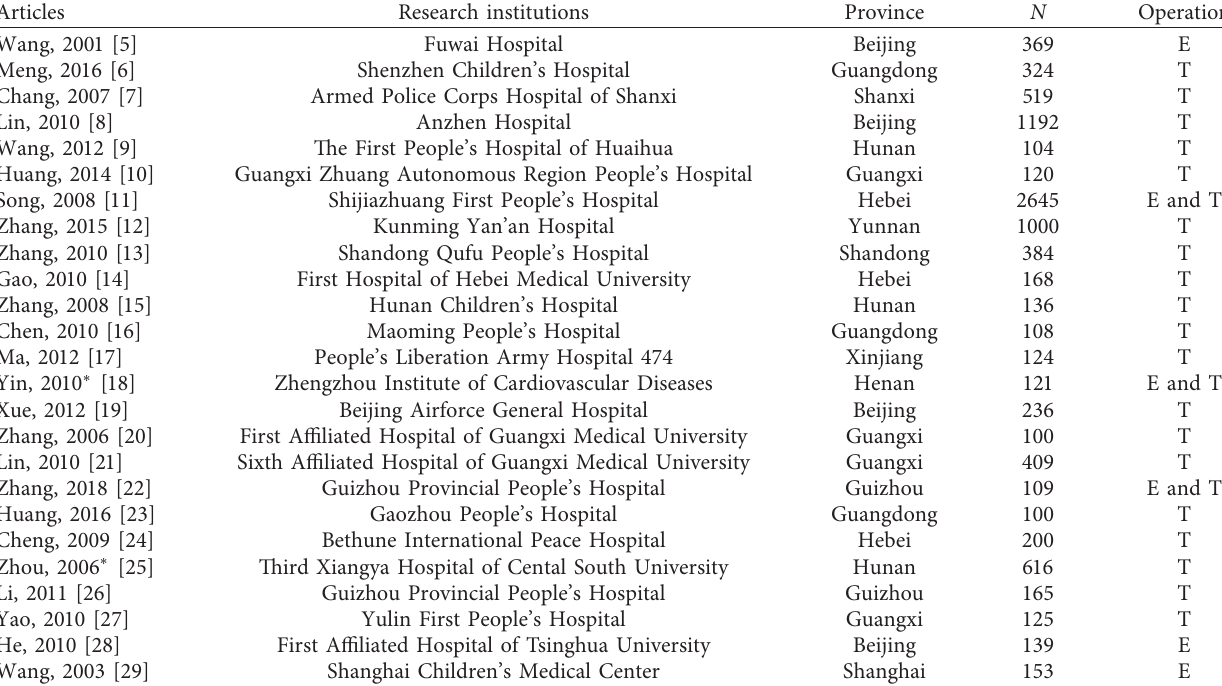
Table 1: Characteristics of the included articles.